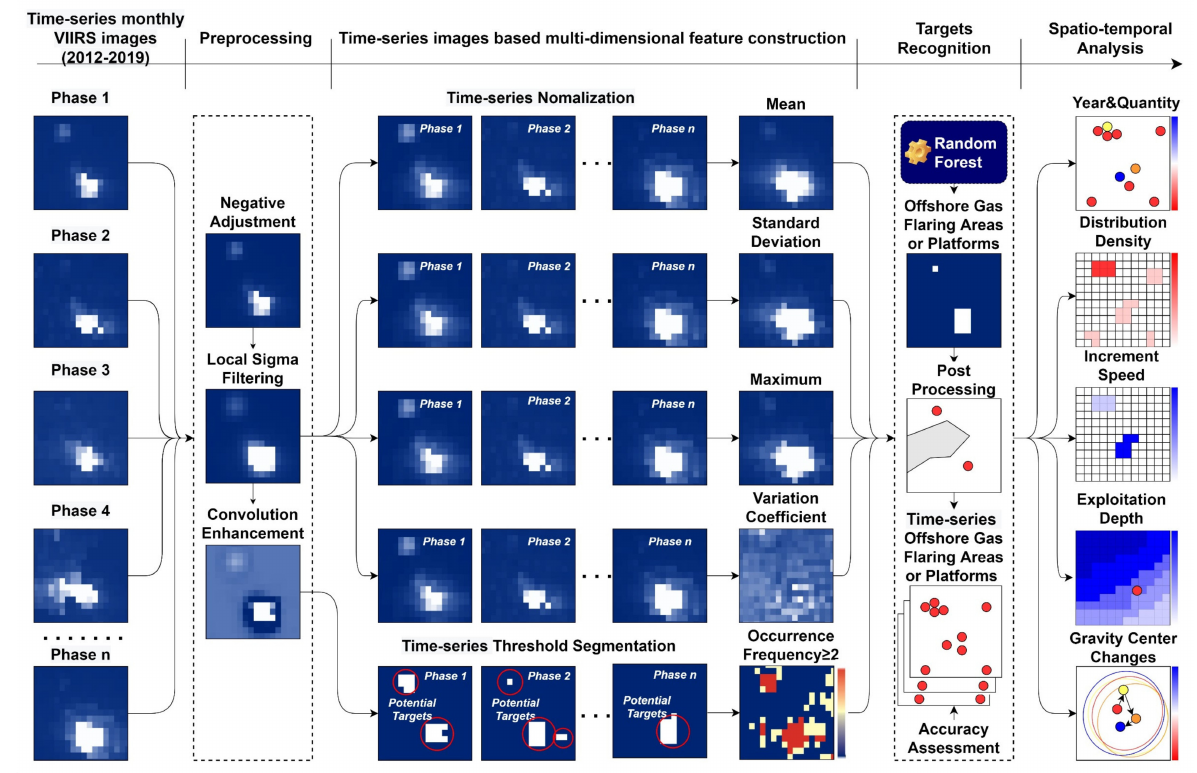
Figure 3. Technical flowchart.